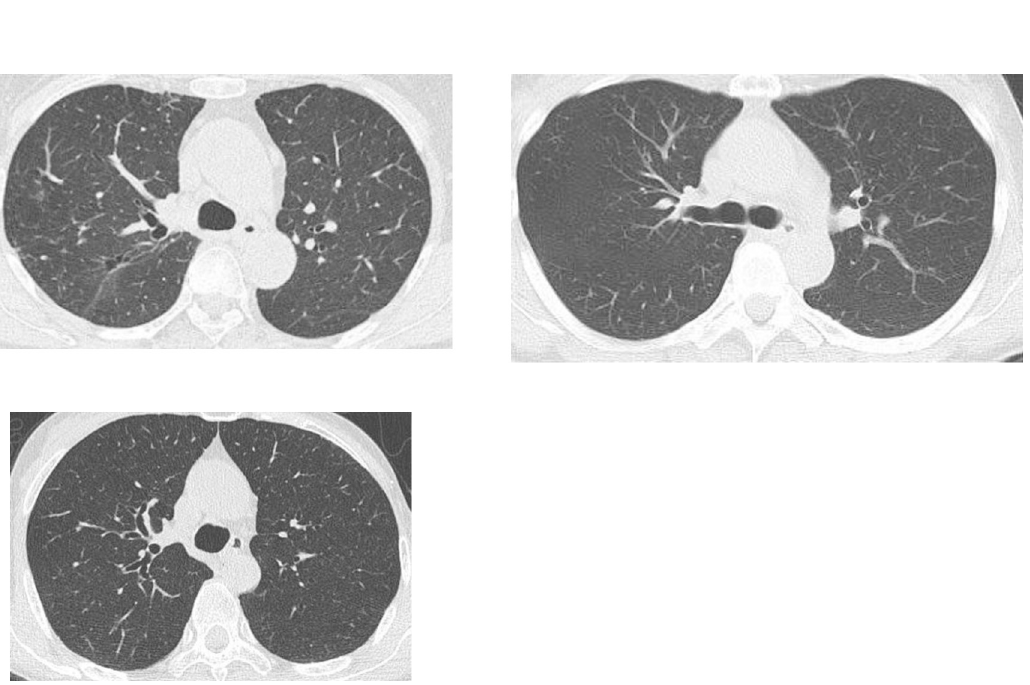
Fig 3. Typical cases of normal esophageal diameter. CT images of three cases whose maximum diameter of esophagus is less than 10 mm were shown.